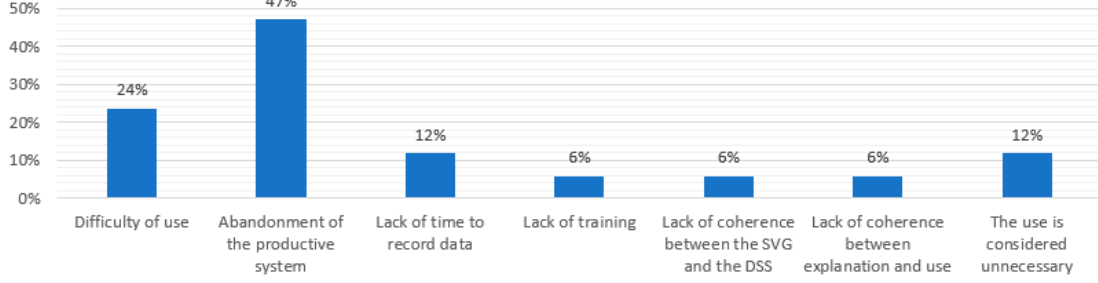
Figure 13. Reasons for abandoning the strategy